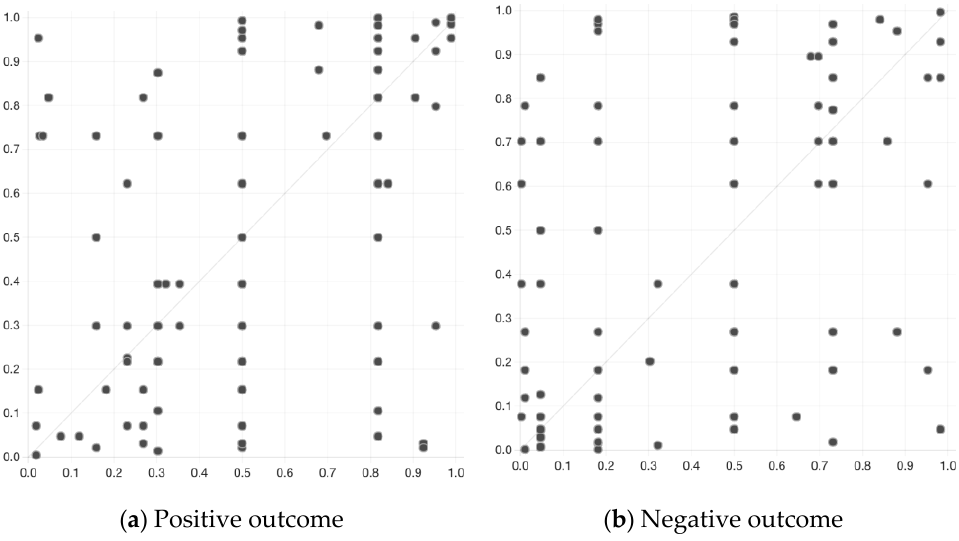
Figure 2. XY plot of positive ( a ) and negative ( b ) outcome calibrated values (level of anxiety) on the y-axis against the causal combinations in the model (attitudes) on the x-axis.